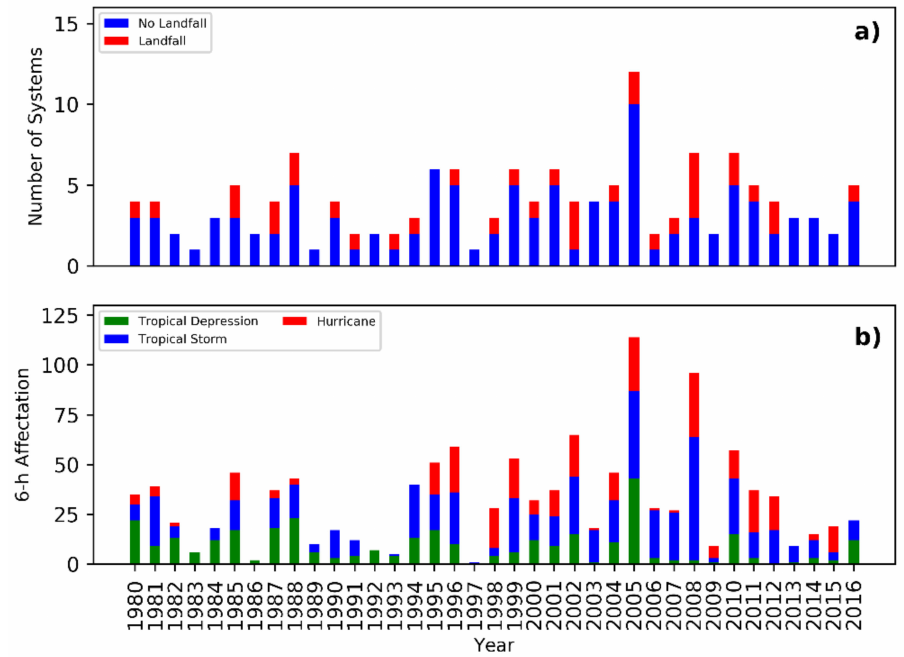
Figure 4. ( a ) Numbers of TCs that made landfall in Cuba (red bars), and that did not make landfall but came within 500 km (blue bars). ( b ) Numbers of TCs in each category (Tropical Depression (TD), Tropical Storm (TS) and Hurricane (HU)) a ff ecting Cuba along their trajectories, accounted every 6 h. Period: